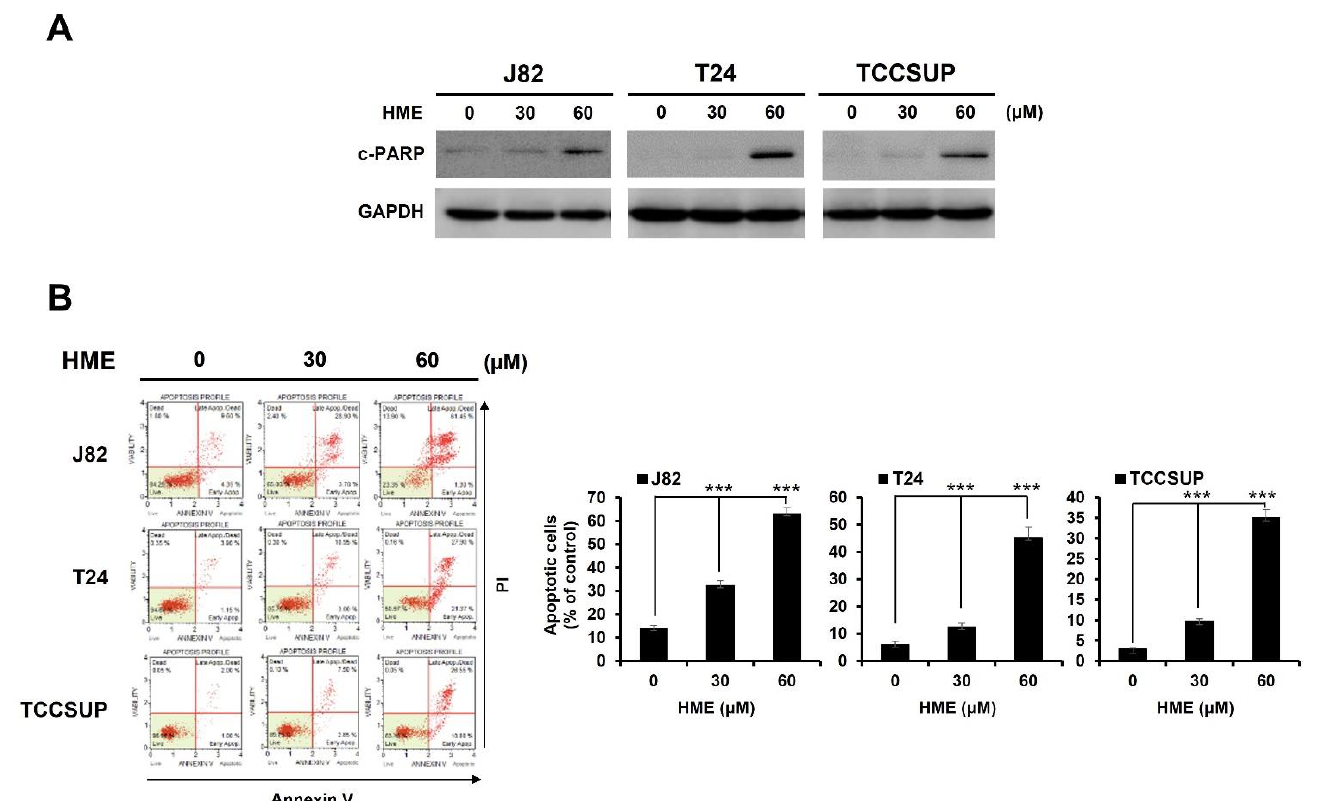
Figure 2. HME’s proapoptotic effect on human bladder TCC cell lines. ( A ) Induction of PARP cleavage by HME. J82, T24, and TCCSUP cells were treated with HME (0, 30, 60 µ M) for 24 h, followed by immunoblotting to evaluate the levels of PARP cleavage. The levels of glyceraldehyde- 3-phosphate dehydrogenase (GAPDH) were used as a control for equal loading. c-PARP: cleaved PARP. ( B ) Increase of annexin V-positive (apoptotic) cell population by HME. J82, T24, and TCCSUP cells were treated with HME (0, 30, 60 µ M) for 24 h, followed by flow cytometry-based annexin V/propidium iodide (PI) dual staining as described in Section 4. ***: p <